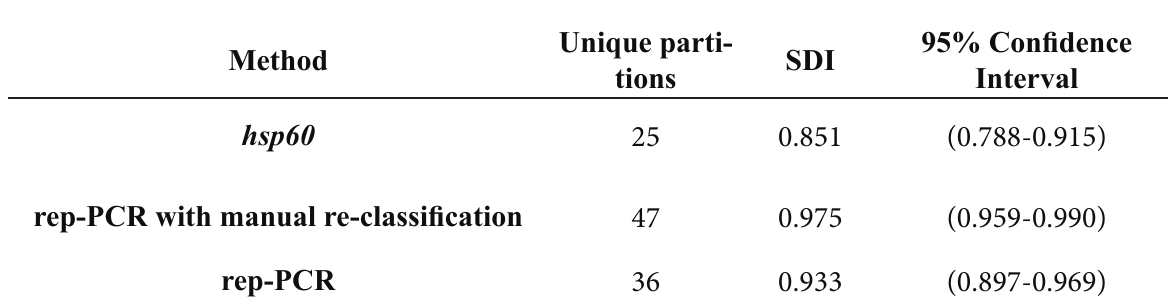
Table 1. Simpson’s Diversity Index for hsp60 sequencing and rep-PCR with 72 isolates of En- terobacter cloacae complex